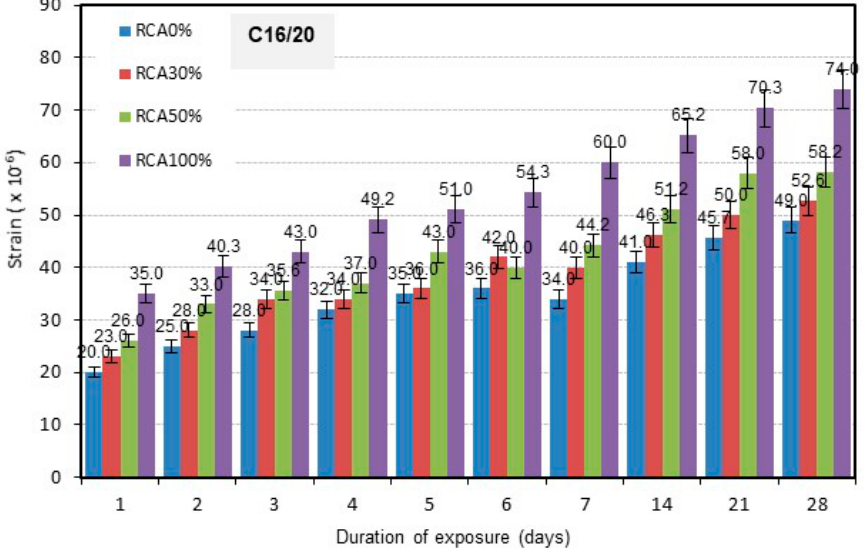
Figure 18. Effect of RCA content on the expansion due to sulphate attack for the C16/20